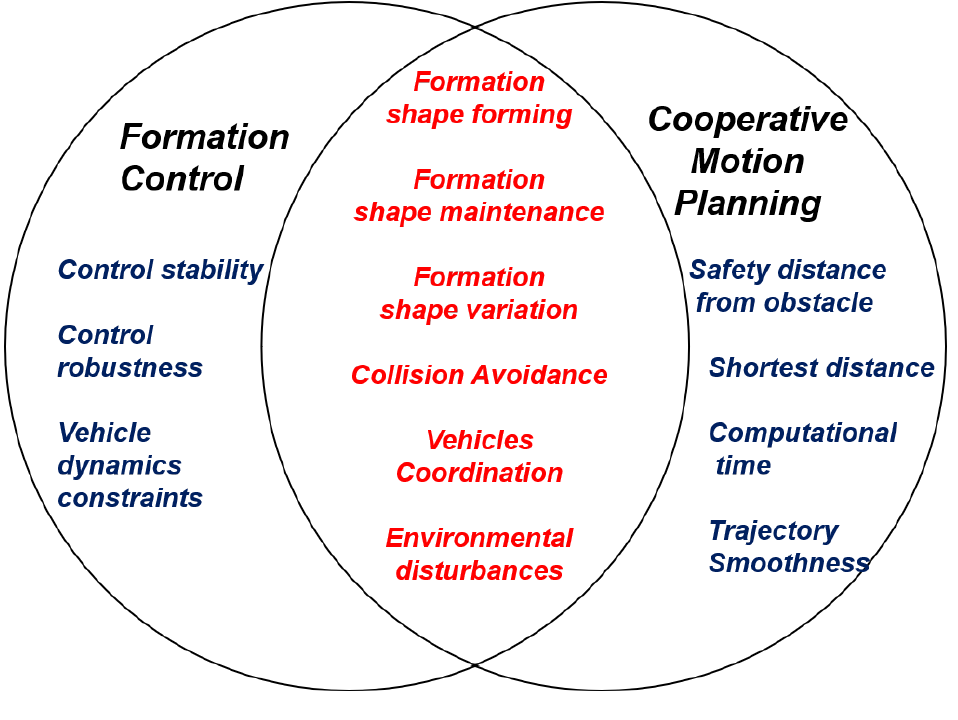
Figure 1. Factors associated with formation control and cooperative motion planning (Source: modified from